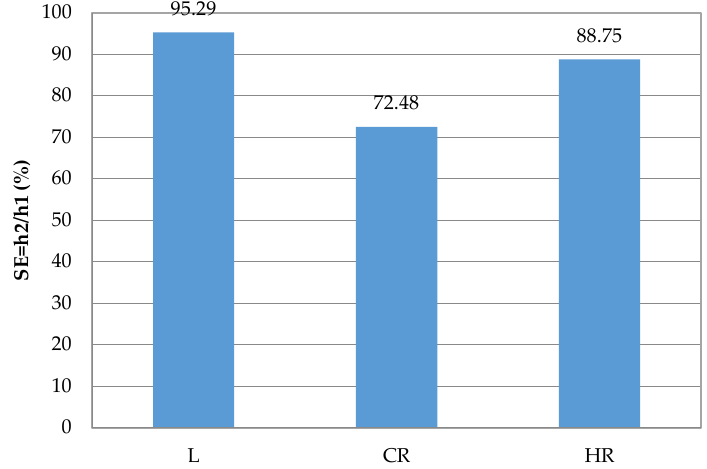
Figure 5. Results of sand equivalent test. L: crushed limestone; CR: crushed hardened concrete from returned concrete; HR: crushed hardened concrete from test specimens of at least 40 MPa compressive strength.